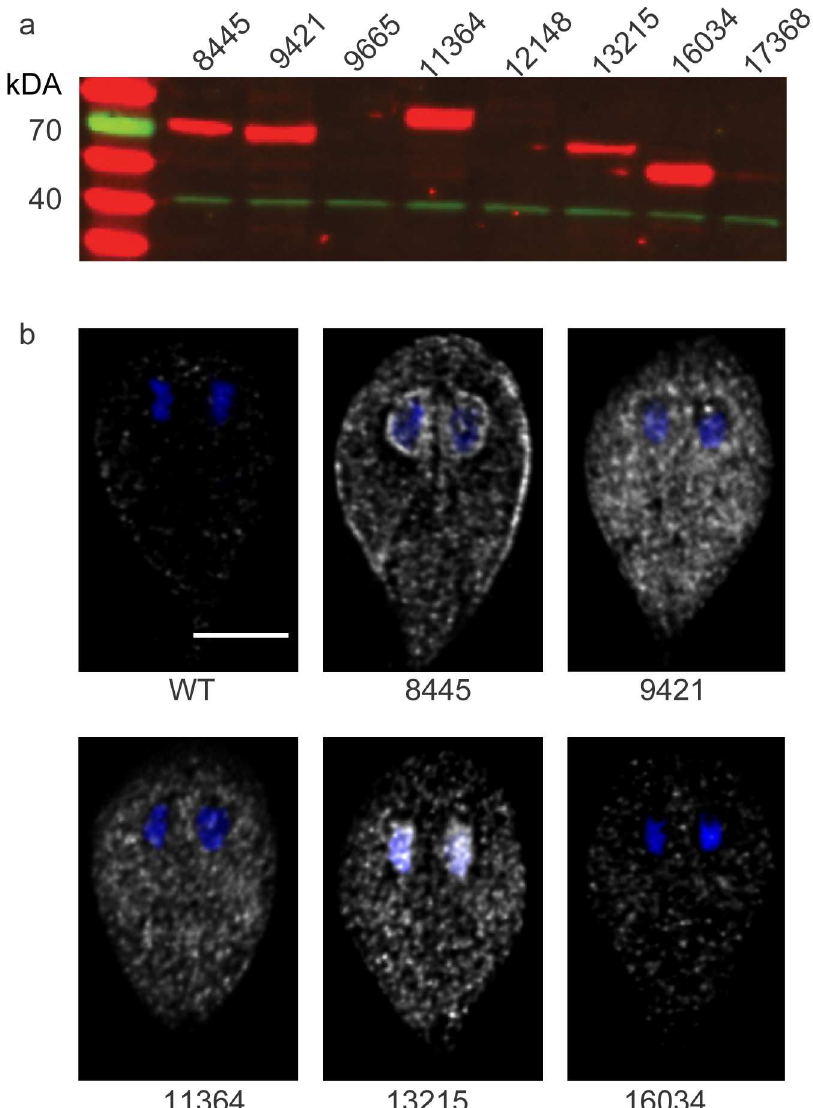
Fig 4. Integration of 3xHA tag allows visualization of protein expression and localization. (a) Western blot analysis showingkinases Gl50803_8445, Gl50803_9421, Gl50803_11364, Gl50803_13215 and Gl50803_16034 are expressedin trophozoites (red). Actin (green) was used as a loadingcontrol. (b) Immunofluorescence imagingof trophozoites expressing the designatedprotein: HA (grayscale) and DAPI (blue). Images were acquired and scaled identically.Representative images are shown from a minimum of 150 cells examinedfor each line. Scale bar = 5 μ